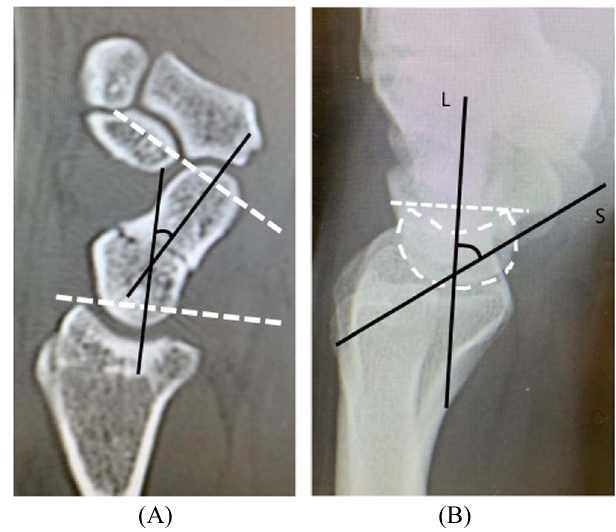
Figure 1. Method for the measurement of the intrascaphoid angle (ISA) (A) and scapholunate angle (SLA) (B). (A) ISA was measured as the angle between the perpendicular lines on the distal and proximal articular surfaces of the scaphoid in the lateral CT image. (B) SLA was measured as the angle between the long axis of the scaphoid (tangent on the volar cortex of the scaphoid) and the long axis of the lunate (axis connecting the midpoints of the proximal and distal arcs) in the lateral view of plain radiography of the